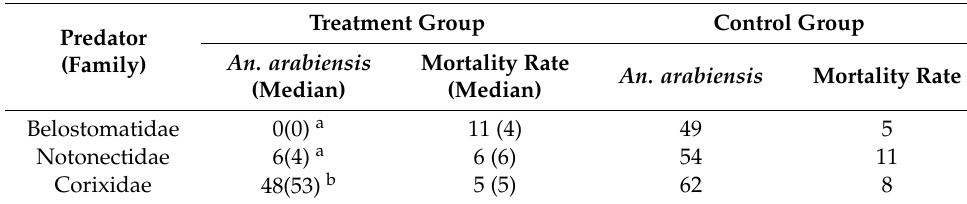
Table 1. Percentage of An. arabiensis mosquitoes emerged and mortality rates of Anopheles larvae collected from